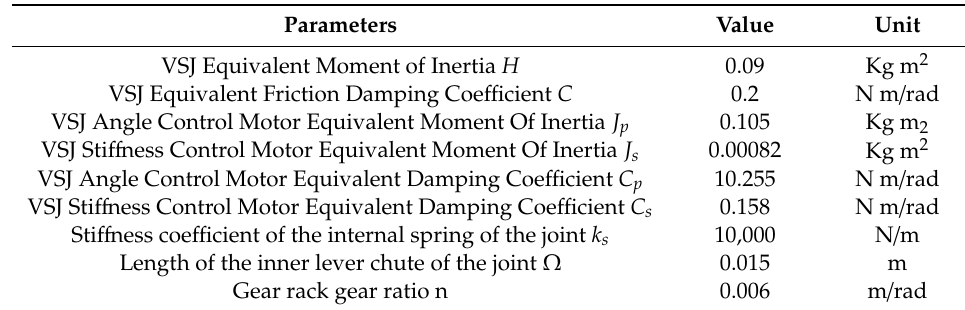
Table 2. VSJ system compound disturbances.